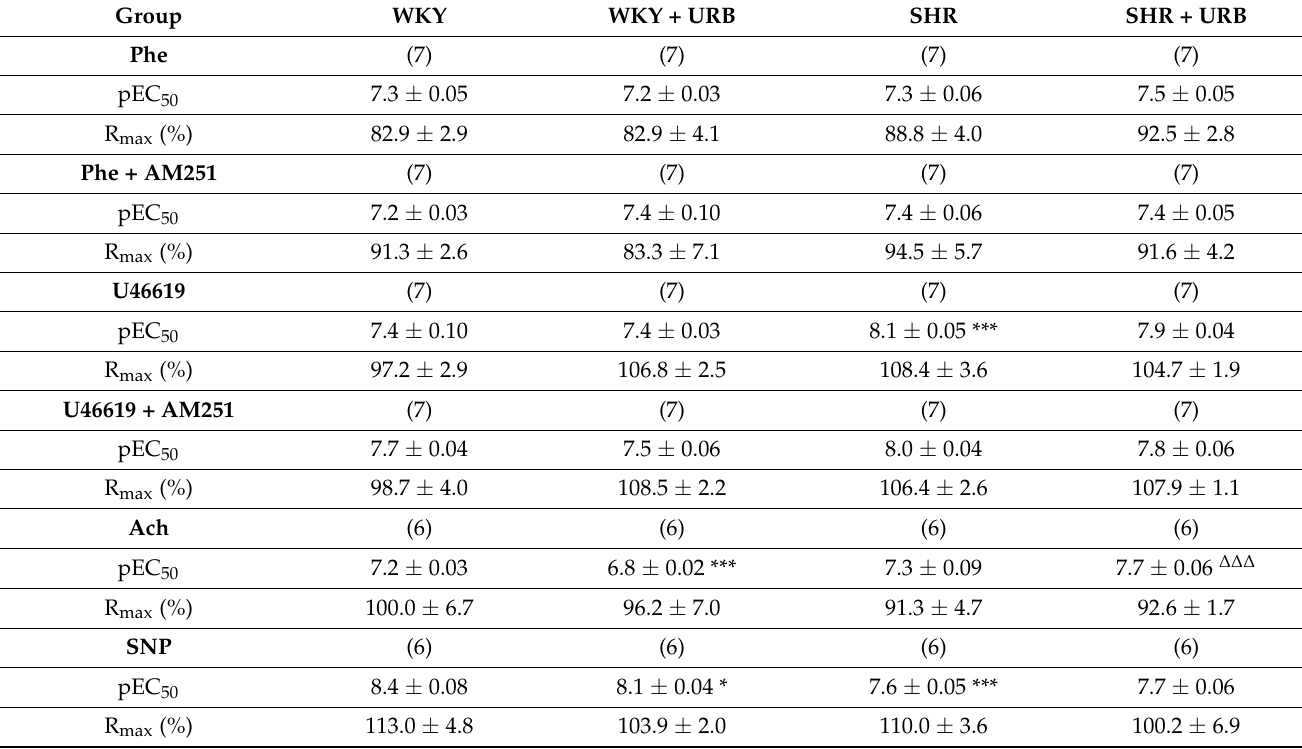
Table 2. The influence of AM251 (1 µ M) on the vasoconstriction to phenylephrine (Phe) and thromboxane analog U46619 and vasorelaxant effects of acetylcholine (Ach) and sodium nitroprusside (SNP) in the endothelium-intact aortas from normotensive rats: control (WKY) and URB597-treated (WKY + URB), or hypertensive rats: (SHR) and URB597-treated (SHR +